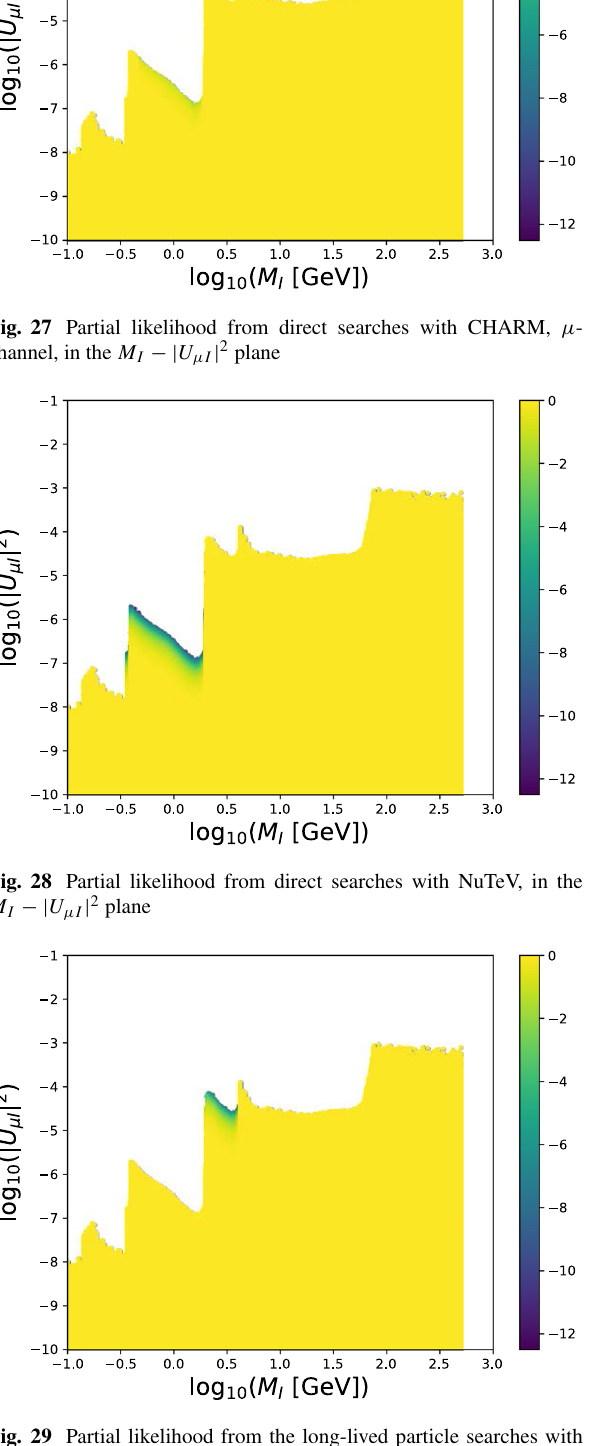
Fig. 29 Partial likelihood from the long-lived particle searches with DELPHI, in the M I − | U μ I | 2 plane